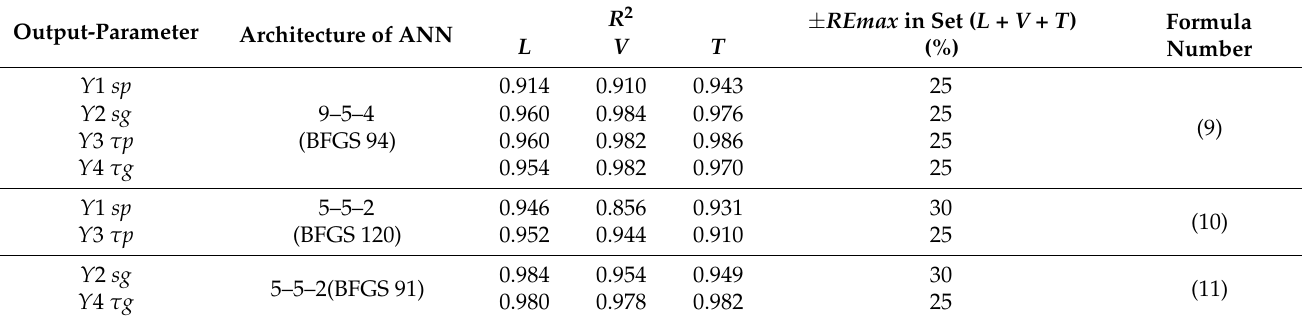
Table 6. ANNs with the best prediction accuracy and its error